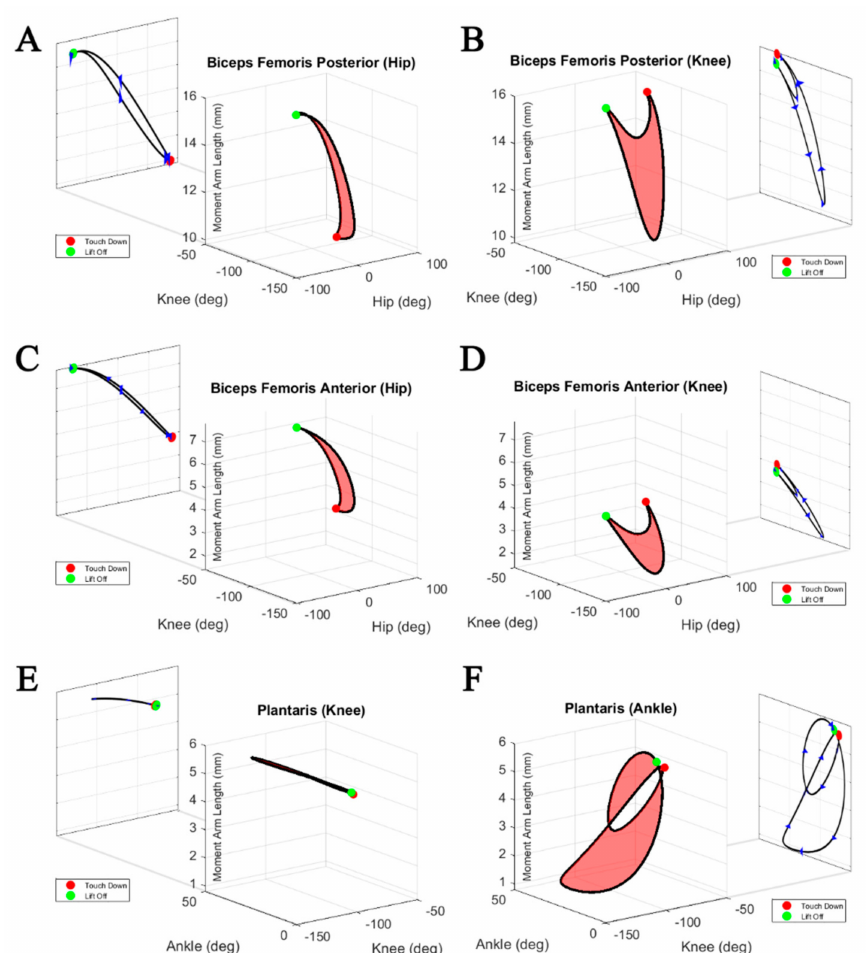
Figure 8. Moment arm profiles of ( A,B ) the biceps femoris posterior, ( C,D ) biceps femoris anterior, and ( E,F ) plantaris as calculated about their spanned joints over a physiological walking profile. Muscle moment arm length travels along the outside of the surface over the step cycle. Projections of the profile are shown to the side, representing the profile shape for a single joint motion. Arrows indicate the development of the moment arm over the step cycle, and colored dots represent touch down (red) and lift off (green). Joint angles follow the zero-angle conventions established by Johnson et al. [17] and Charles et al.